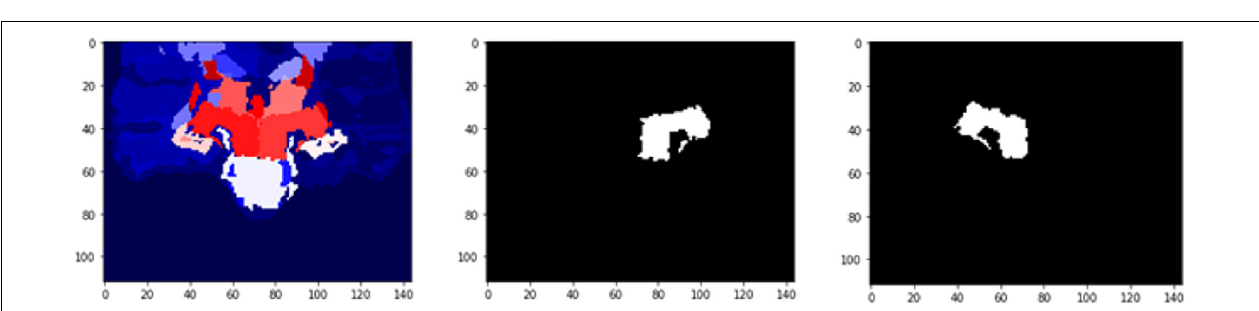
Frontiers in Aging Neuroscience |